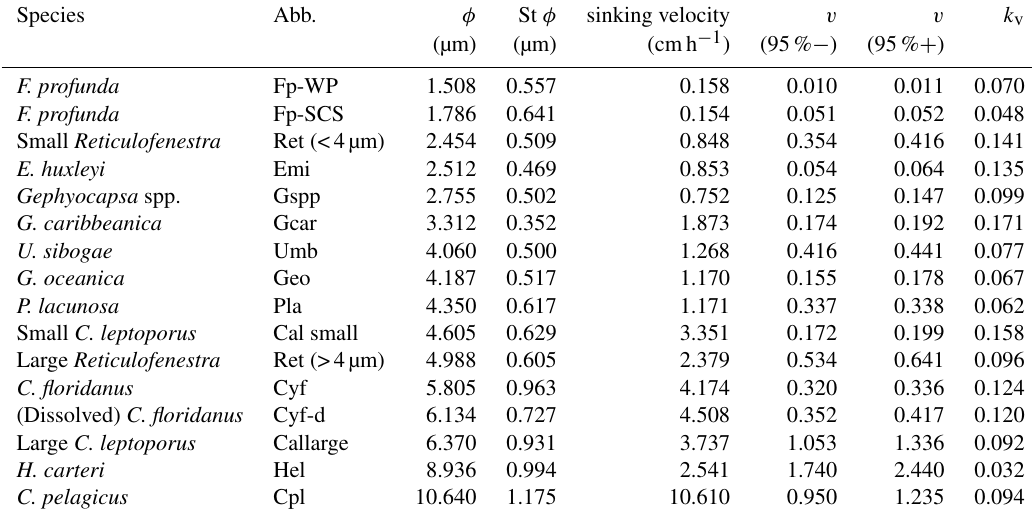
Table 2. The sinking velocity and shape–velocity factor of different coccolith species: φ means the distal shield length of coccolith and St φ is the standard deviation of distal shield length; sv represents the sinking velocity; v (95% − ) and v (95% + ) represent the lower and higher limit of 95% confidence level, respectively; k v represents the length-sinking velocity factor. The abbreviated name of coccoliths can be found in the caption of Fig. 4. The details of coccolith length distribution are found in Appendix